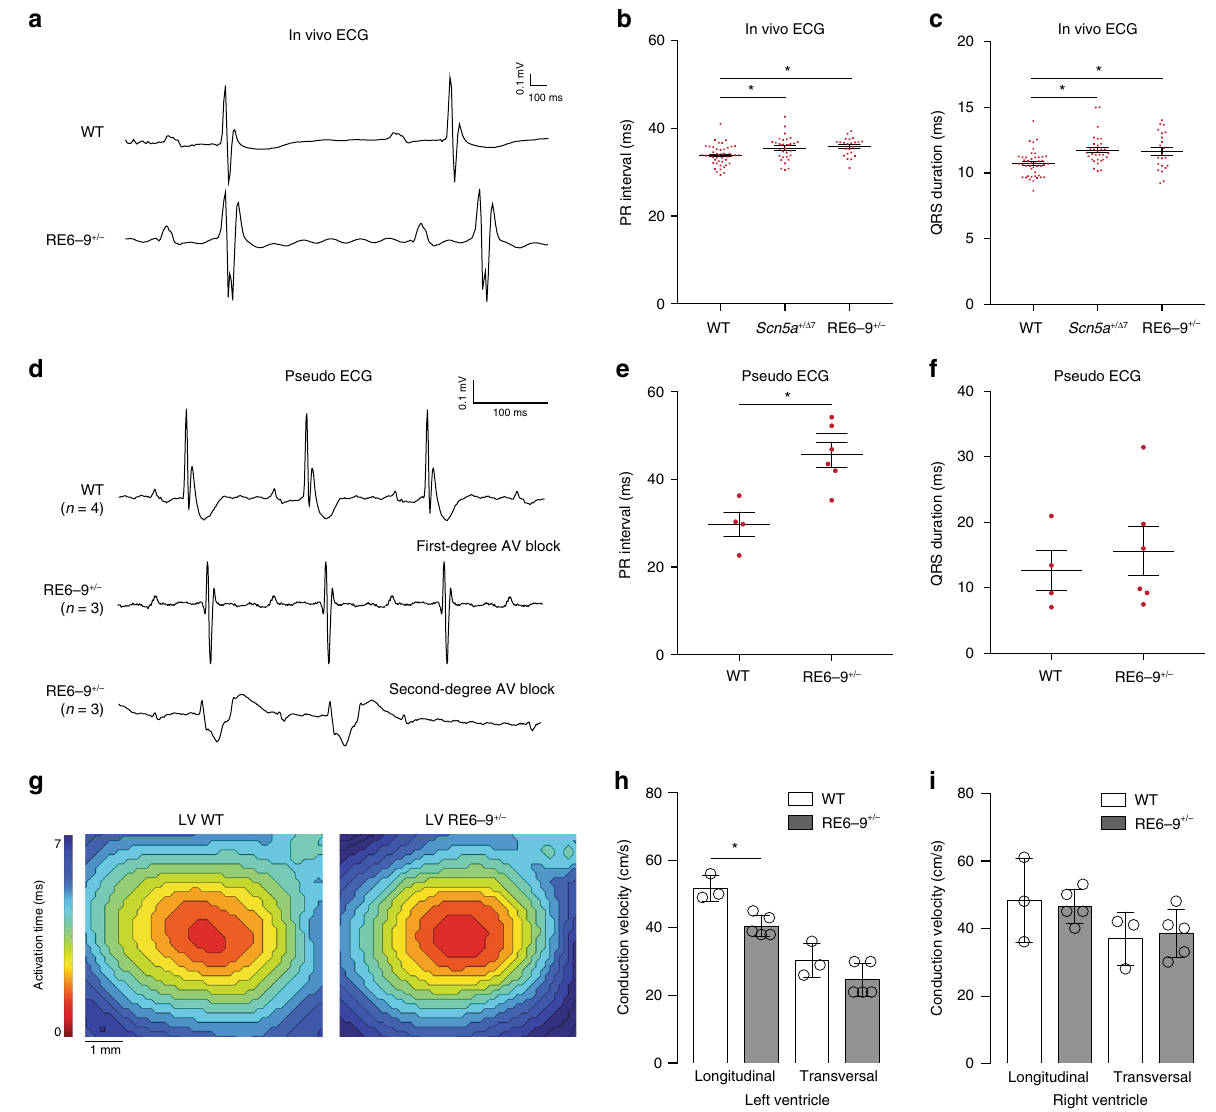
Fig. 6 Deletion of the enhancer cluster RE6-9 causes conduction slowing. a Electrograms recorded in vivo from a wildtype (WT) and RE6-9 + / − mouse. b , c Scatter graph showing values for PR interval ( b ) and QRS duration ( c ) in vivo in 8 to 13-week old WT, Scn5a + / Δ 7 , and RE6-9 + / − mice. P values were calculated using one-way ANOVA with post-hoc Bonferroni tests. Left panel ( b ): WT n = 45; Scn5a + / Δ 7 n = 32; RE6-9 + / − n = 23, right panel ( c ): WT n = 44; Scn5a + / Δ 7 n = 31; RE6-9 + / − n = 22. * P < 0.05. d An example of electrograms recorded from Langendorff-perfused hearts from a WT and RE6-9 + / − mouse with fi rst-degree AV block and RE6-9 + / − with second-degree AV block (Wenkebach). e , f Scatter graph showing values for PR interval ( e ) and QRS duration ( f ) ex vivo in 8 to 13-week old WT and RE6-9 + / − mice. P values were calculated using unpaired Student ’ s t test. WT n = 4; RE6-9 + / − n = 6. * P < 0.05. g Reconstructed activation patterns of the left ventricle from a WT and RE6-9 + / − mouse. h , i Left ( h ) and right ( i ) ventricular conduction velocity at longitudinal and transversal pacing in 8 to 13-week old WT and RE6-9 + / − mice. P values were calculated using unpaired Student ’ s t test. WT n = 3; RE6-9 + / − n = 5. * P < 0.05. Bars represent mean ± SEM. Source data are provided as a Source Data fi